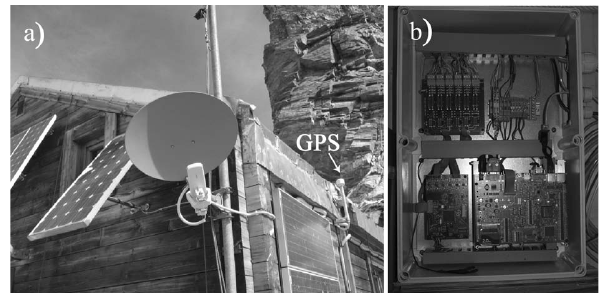
Fig. 3. (a) The parabolic aerial, the gps and the solar panels installed on the J. A. Carrel hut; (b) the acquisition system installed inside the hut (images modified after Signori and Bani, 2007).